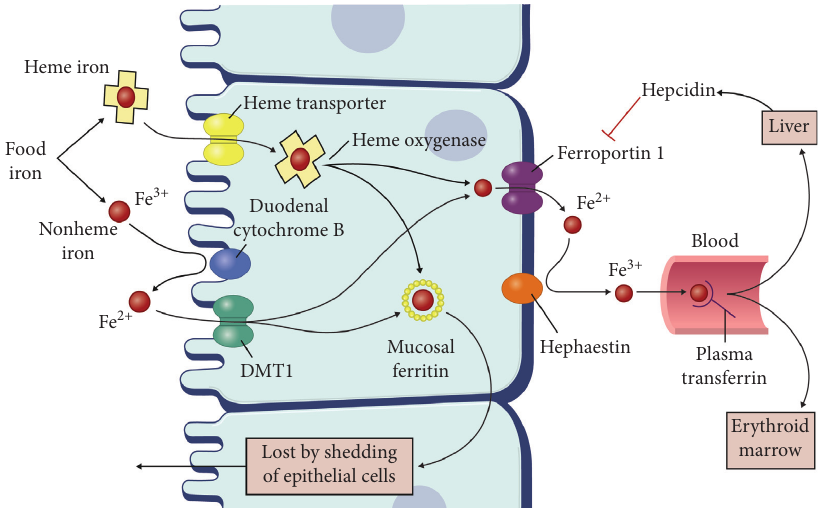
Figure 1: Mechanisms of intestinal iron absorption. Most iron is absorbed in the duodenum and proximal jejunum due to the acidic pH of the intestinal content. More, distally in the jejunum, pH becomes neutral or alkaline, and iron uptake declines. Nonheme food iron Fe 3+ enters the nonheme iron pool and heme iron enters the heme iron pool. Fe 3+ is reduced to Fe 2+ by duodenal cytochrome B and subsequently enters the luminal side of the enterocyte by the iron importer DMT-1 pathway. Fe 2+ is transferred to the basolateral side of the enterocyte, effluxed by the iron exporter ferroportin, and subsequently oxidized to Fe 3+ by hephaestin and transferred to the carrier protein transferrin in the blood plasma. Part of the iron enters the intracellular ferritin iron pool and is lost by desquamation of the enterocyte into faeces. Hepcidin from the liver inactivates ferroportin, thereby inhibiting iron uptake. Heme iron is absorbed within the intact protoporphyrin ring by a separate pathway possibly involving a heme transporter and heme oxygenase. Figure adapted with permission from